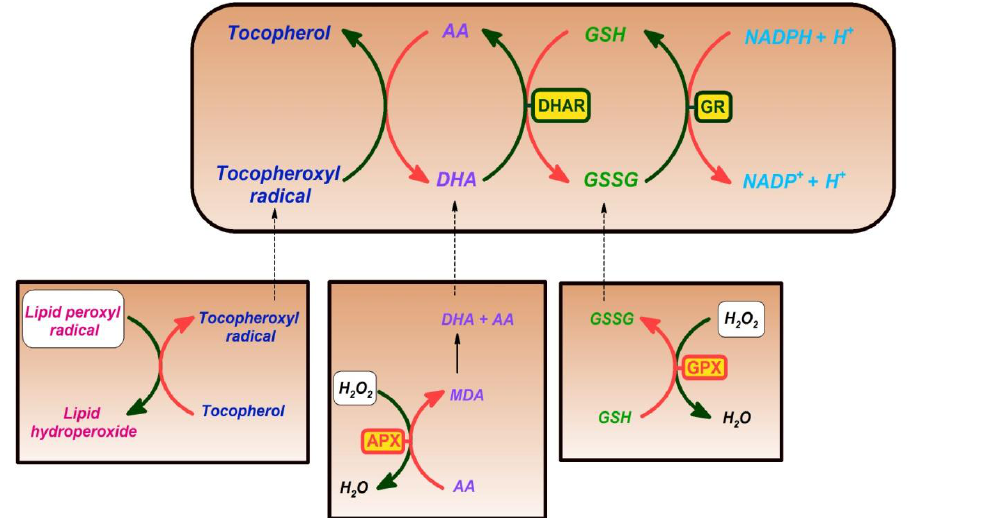
Figure 4. The interdependent ROS scavenging network of the α-tocopherol-ascorbate- glutathione triad. Tocopherols scavenge the lipid peroxy radical before it can abstract hydrogen from the target lipids. Tocopherols lose a hydrogen atom, which is given to the lipid peroxy radical, and tocopheroxyl radical is formed. The tocopheroxyl radical is reduced by ascorbate (Asc), while dehydroascorbate (DHA) is formed. Ascorbate is also involved in the detoxifying process of H O , especially as a substrate of ascorbate 2 2 peroxidase (APX), which generates two molecules of monodehydroascorbate (MDHA). MDHA may be reduced to ascorbate by the catalysis of monodehydroascorbate reductase (MDAR). MDHA may also rapidly oxidize to DHA, which is then reduced to ascorbate by the action of dehydroascorbate reductase (DHAR) with glutathione (GSH) as a substrate, generating glutathione disulfide (GSSG). The alternative way of H O elimination can be 2 2 performed by glutathione peroxidase (GPX) at the expense of GSH. Finally, glutathione reductase (GR) reduces GSSG to GSH on the expense of